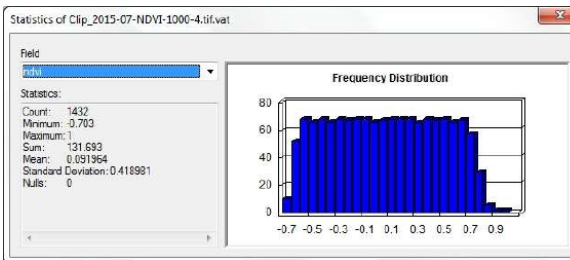
Figure 17. Sector 4 - Distribution frequency 10/07/2015